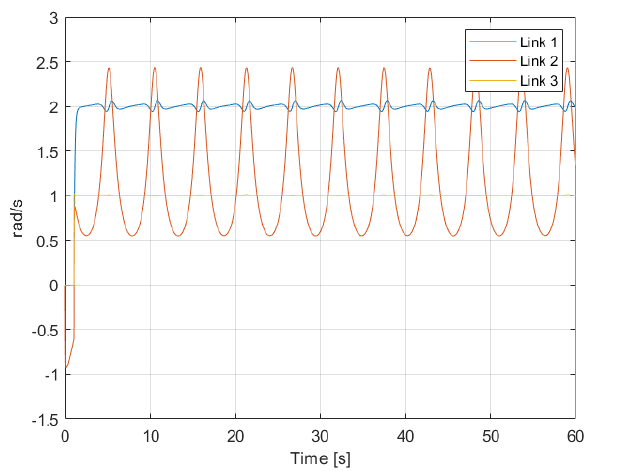
Figure 6. Angular velocity ˙ q of the links in the presence of a constant torque